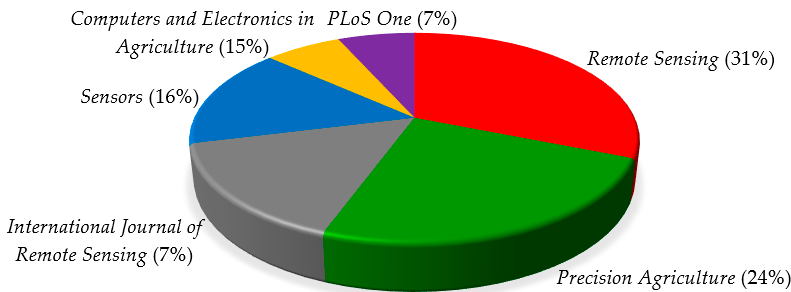
Figure 3. Scientific articles published by researchers from different journals (by 18 June 2021). Geographical analysis showed that the scientific articles were mainly published by researchers from 14 countries: China, Italy, United States of America, India, Germany, Australia, Spain, Greece, Brazil, Japan, France, Denmark, United Kingdom, and Switzerland. (Figure 4).